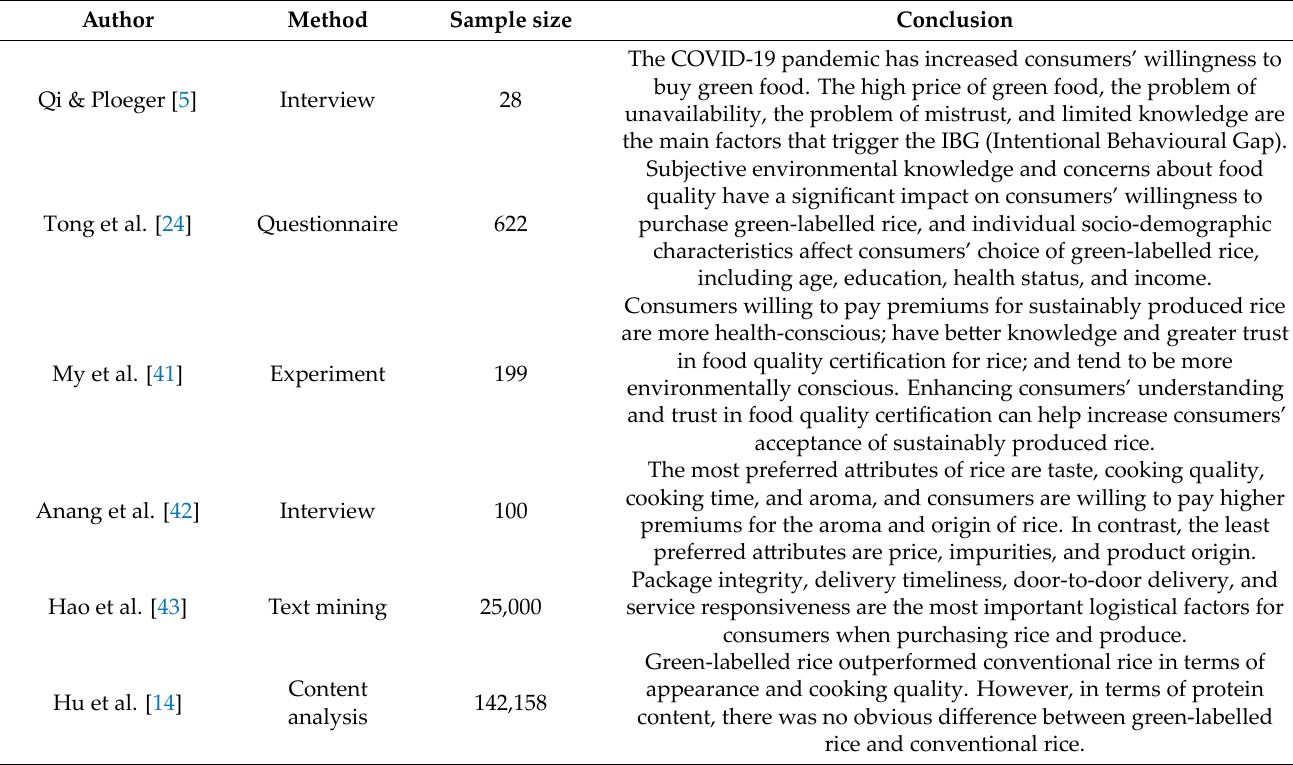
Table 1. Summary of Literature in the Field of Green‑Labelled